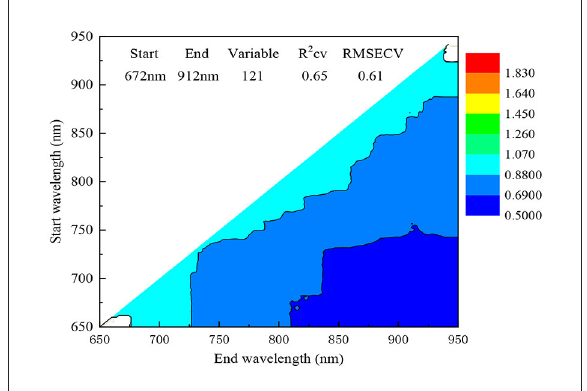
FIGURE4 Variation of RMSECV for SSC by variable selection method of window search.